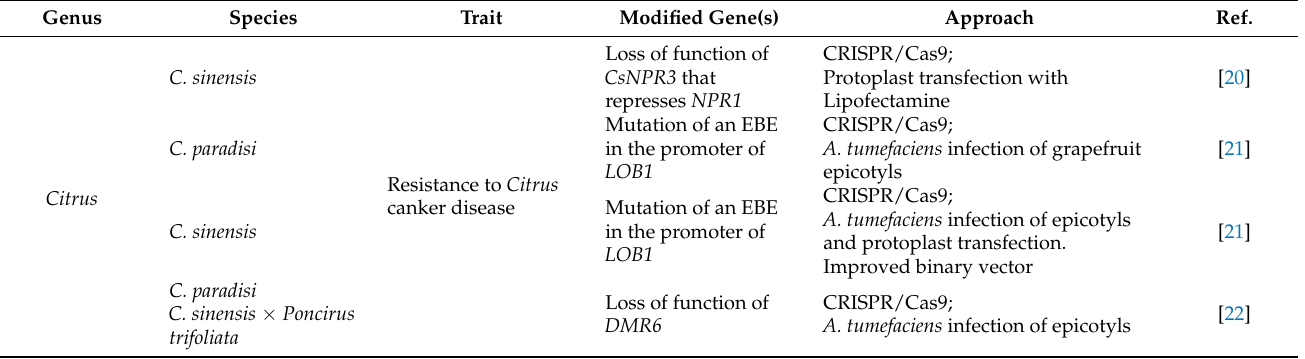
Table 1. State of progress in the application of genetic engineering techniques outside Italy. Many studies report the applications of new genomics techniques and Agrobacterium -mediated transforma- tion using several types of starting explants that are mainly focused on the introduction of resistance to biotic and abiotic stresses in Citrus , Vitis , Castanea , and Malus . In other species such as kiwifruit and strawberries, most recent studies are mainly directed toward the improvement of traits linked to yields and early